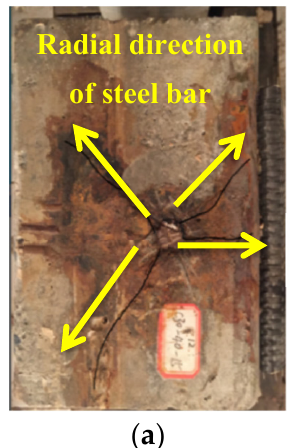
Axial direction of reinforcement